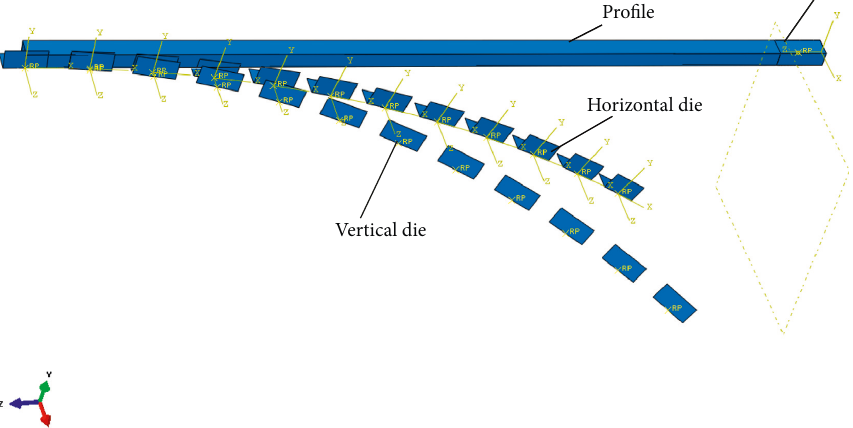
Figure 6: Assembly sketch of the profile.